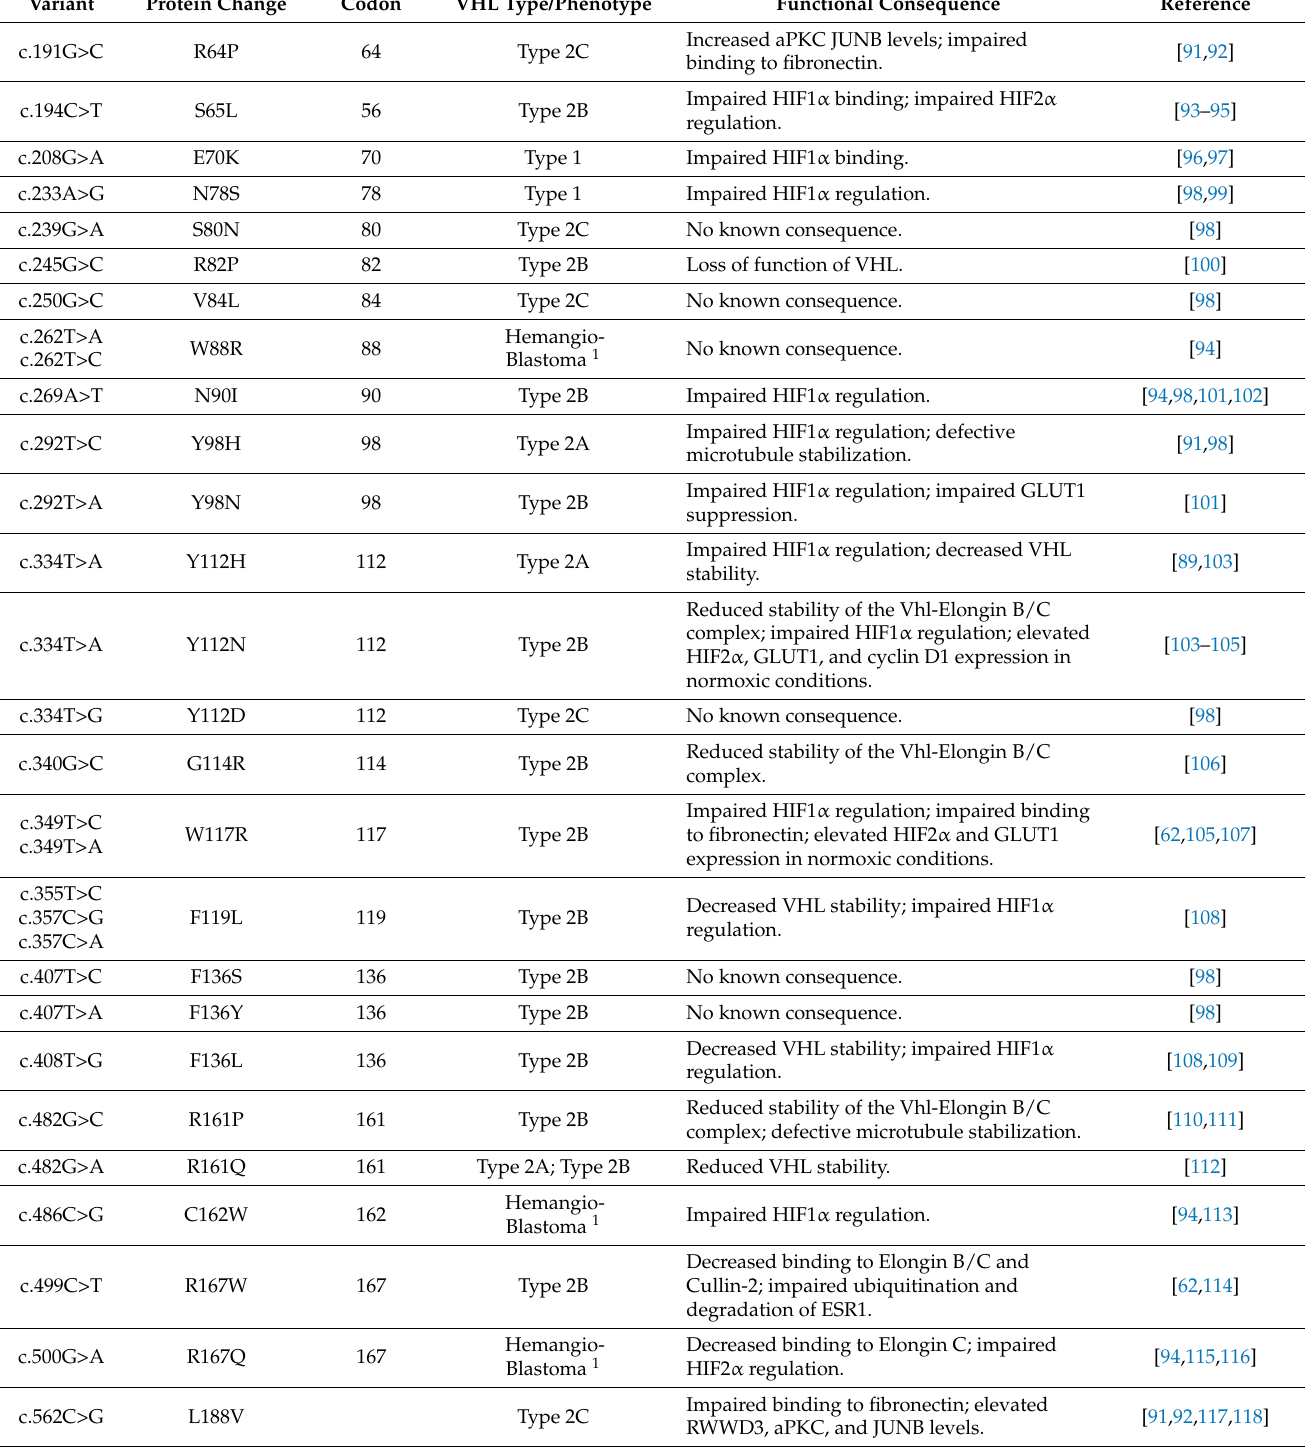
Table 1. Selected VHL genetic variants in VHL disease and their association with